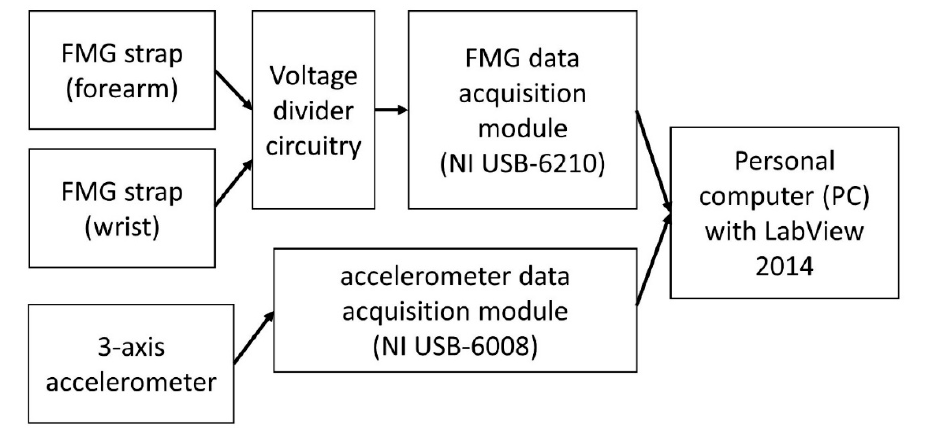
Figure 1. Schematic of the experimental setup.